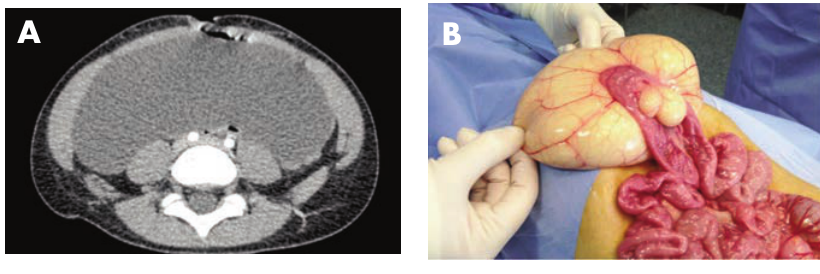
Figure 4. Magnetic resonance imaging coronal view of the cystic mass (retroperi- toneal cystic